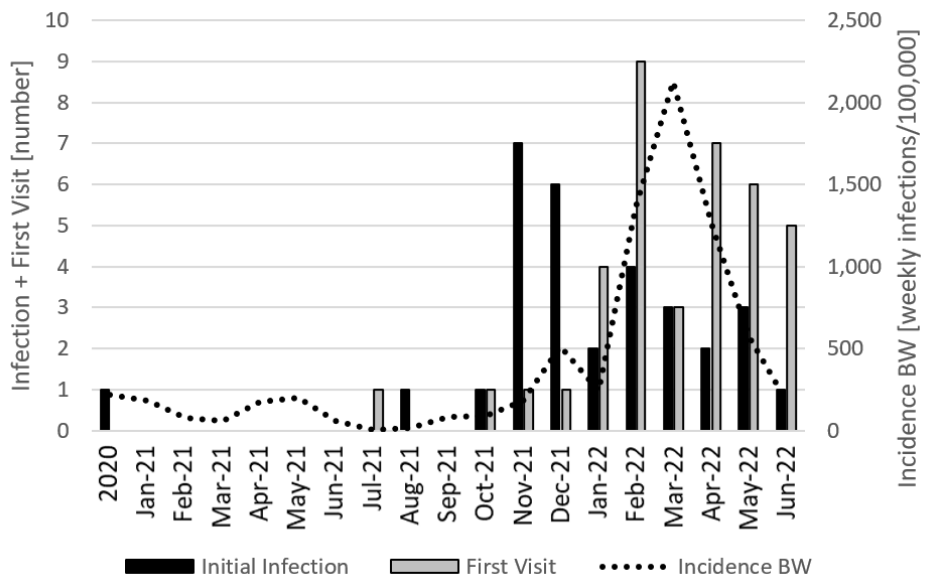
Figure 1. Timeline between initial SARS-CoV-2 infection/vaccination and first visit of cause of post- acute sequelae (PASC). X-axis: time; left Y-axis : number of initial infections and first visits in this month. Right Y-axis : Monthly new SARS-CoV-2 infections in Baden-Württemberg (State in southern Germany, BW).